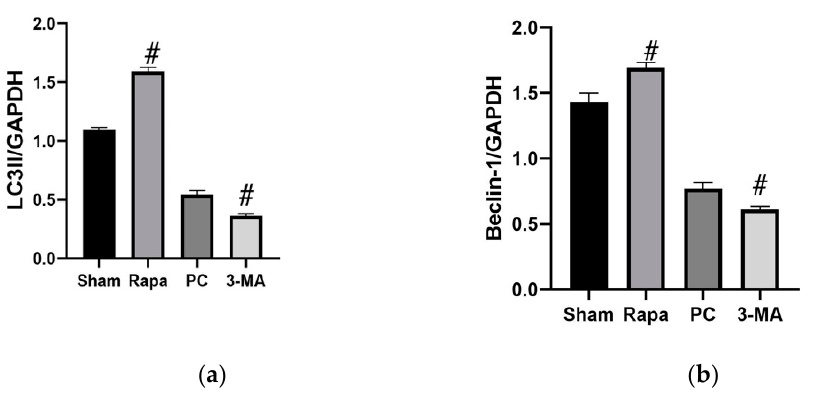
Figure 4. Changes in autophagy after 12 h long preservation. Panels ( a ) and ( b ) show changes in immunoblot for LC3II and Beclin-1, respectively. Each protein is represented as a ratio of GAPDH. Data are mean ± SEM, n = 6. # p ≤ 0.05 versus PC. Electrophoresis patterns for LC3II and Beclin-1 are available as supplementary materials (S2.2).